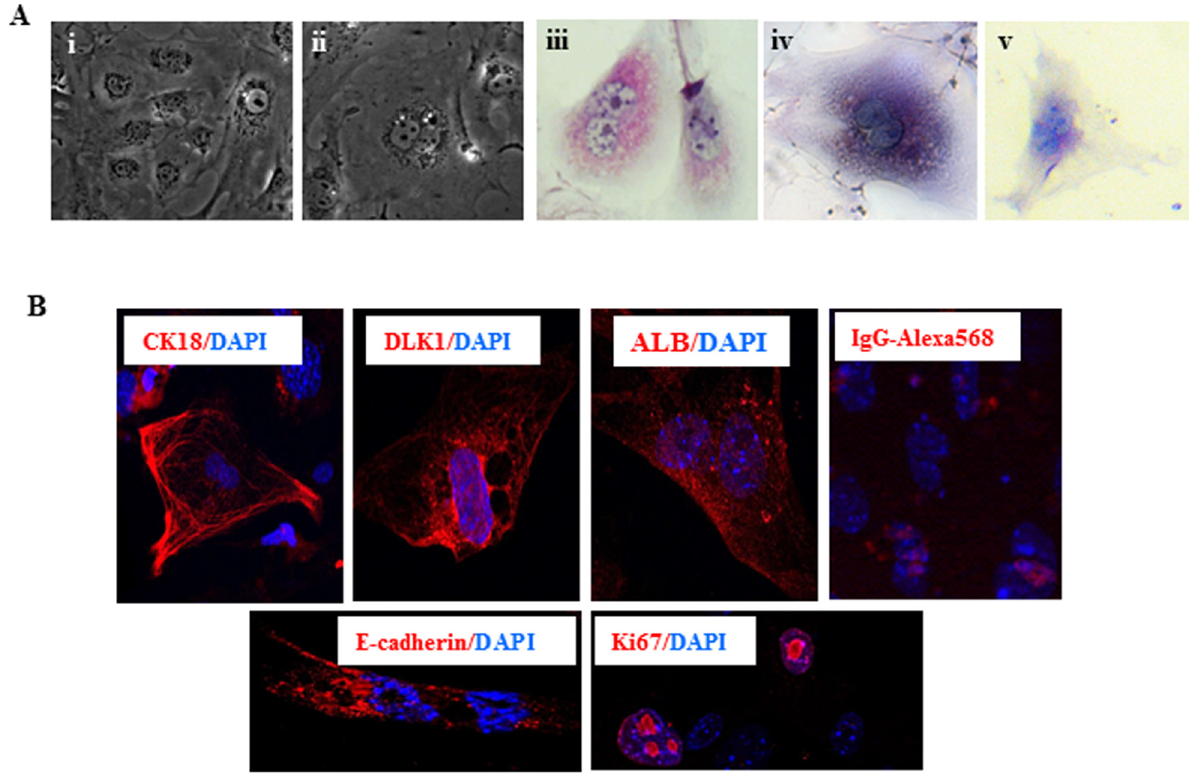
Fig 3. Characterisation of Liv2-sorted GPSC-derived hepatocytes. A. Liv2-sorted cells show the typical hepatocyte morphology: binuclear cells with prominent cytoplasm (i, ii) and are positive for glycogen deposits as revealed by PAS staining (iii). PAS staining of non-sorted GPSC-derived hepatocytes are shown as positive control (iv) while mouse embryonic fibroblasts were used as negative control (v) B. Immunostaining of Liv2-sorted cells showed positivity for hepatocyte markers CK18, Dlk1, albumin and E-cadherin. These cells were also positive for Ki67, a proliferation marker. Cells were stained with secondary antibody (IgG-Alexa568) only for negative control. Representative images are